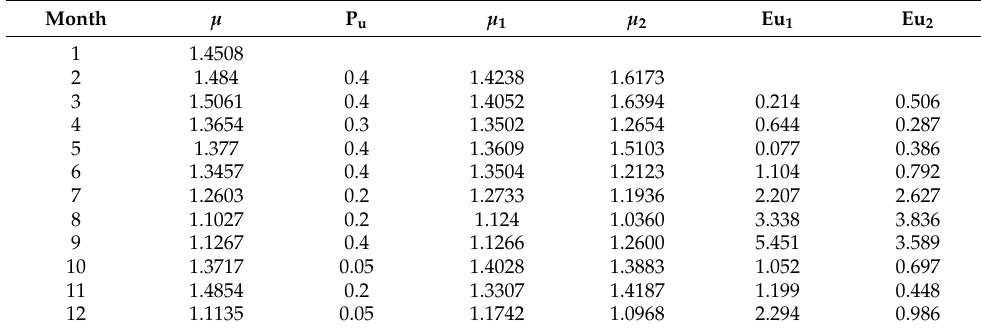
Table 9. Monthly forecasting error of u parameter.